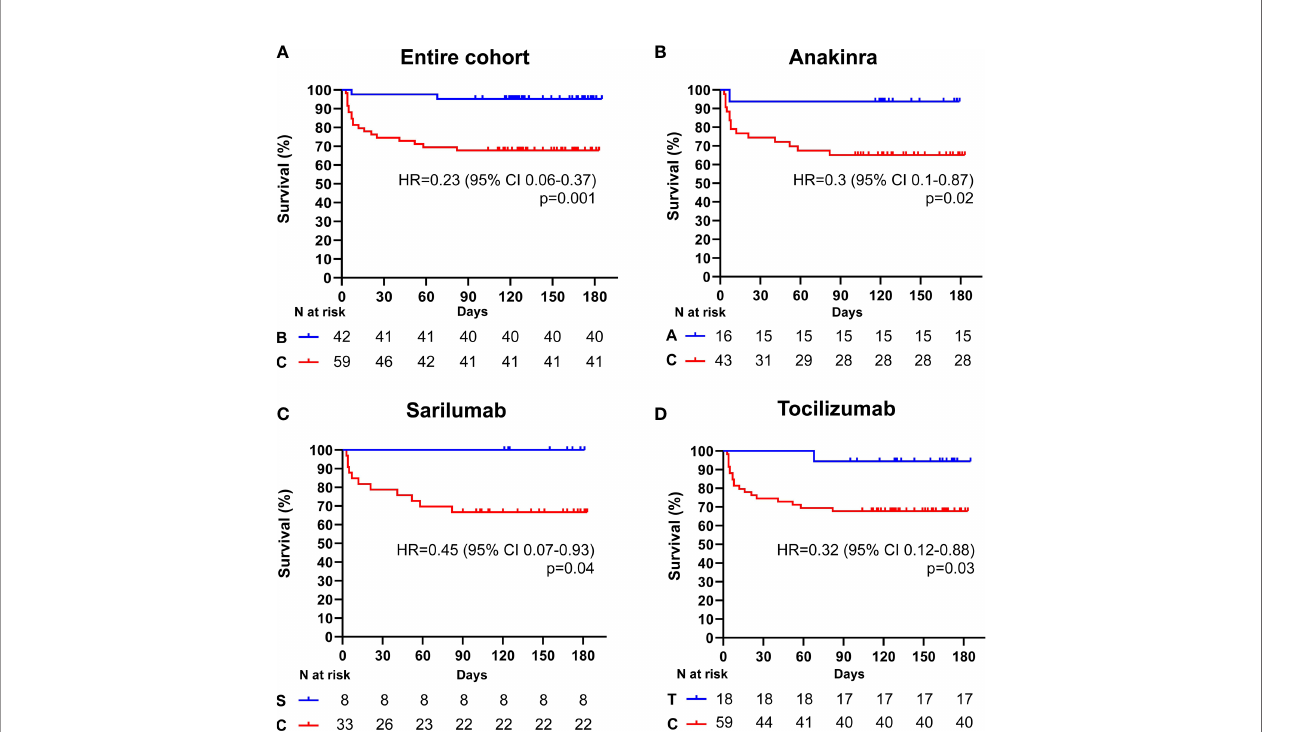
FIGURE 2 | Cumulative incidence of long-term survival of patients treated with biologic drugs compared to patients treated with standard of care (PaO2/FiO2 ratio ≥ mmHg). Kaplan-Meier curves showing the cumulative incidence of overall survival up to 186 days of patients presenting with a PaO2/FiO2 ratio ≥ mmHg and treated with biologic drugs (A) , anakinra (B) , sarilumab (C) , and tocilizumab (D), compared to standard of care. Time to death is expressed in days from the day of enrolment. A, anakinra; B, biologic drugs; C, comparators treated with standard of care; S, sarilumab; T, tocilizumab; HR, hazard ratio; CI, con fi dence interval. Statistically signi fi cant p value <